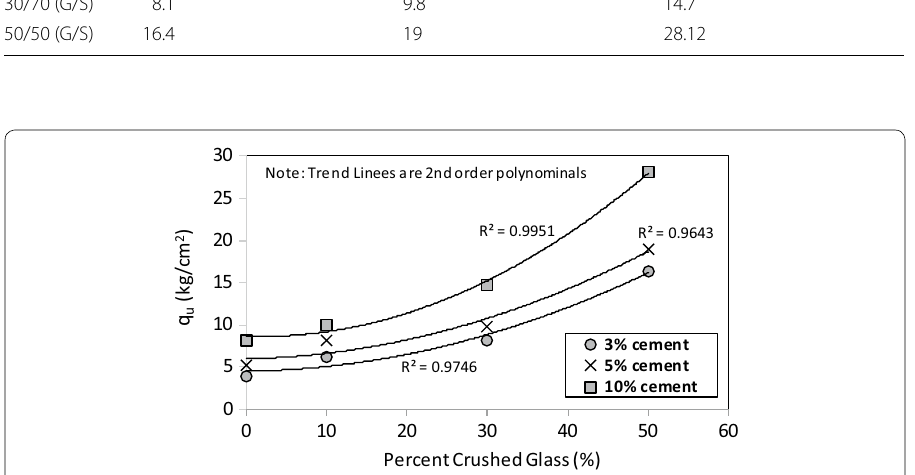
Fig. 5 Unconfined compressive strength for stabilized SM and CG–SP